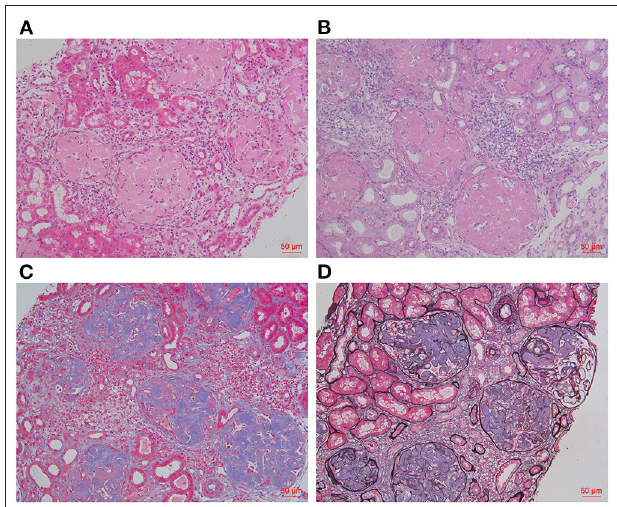
FIGURE 1 | Histology findings of renal biopsy. HE [ (A) , × 200] and PAS [ (B) , × 200] staining showed massive amorphous eosinophilic deposits in glomeruli, leading to the obliteration of glomerular capillary loops. These amyloid deposits were pale blue by Masson trichrome staining [ (C) , × 200], but were not black on Silver methenamine staining [ (D) , × 200].